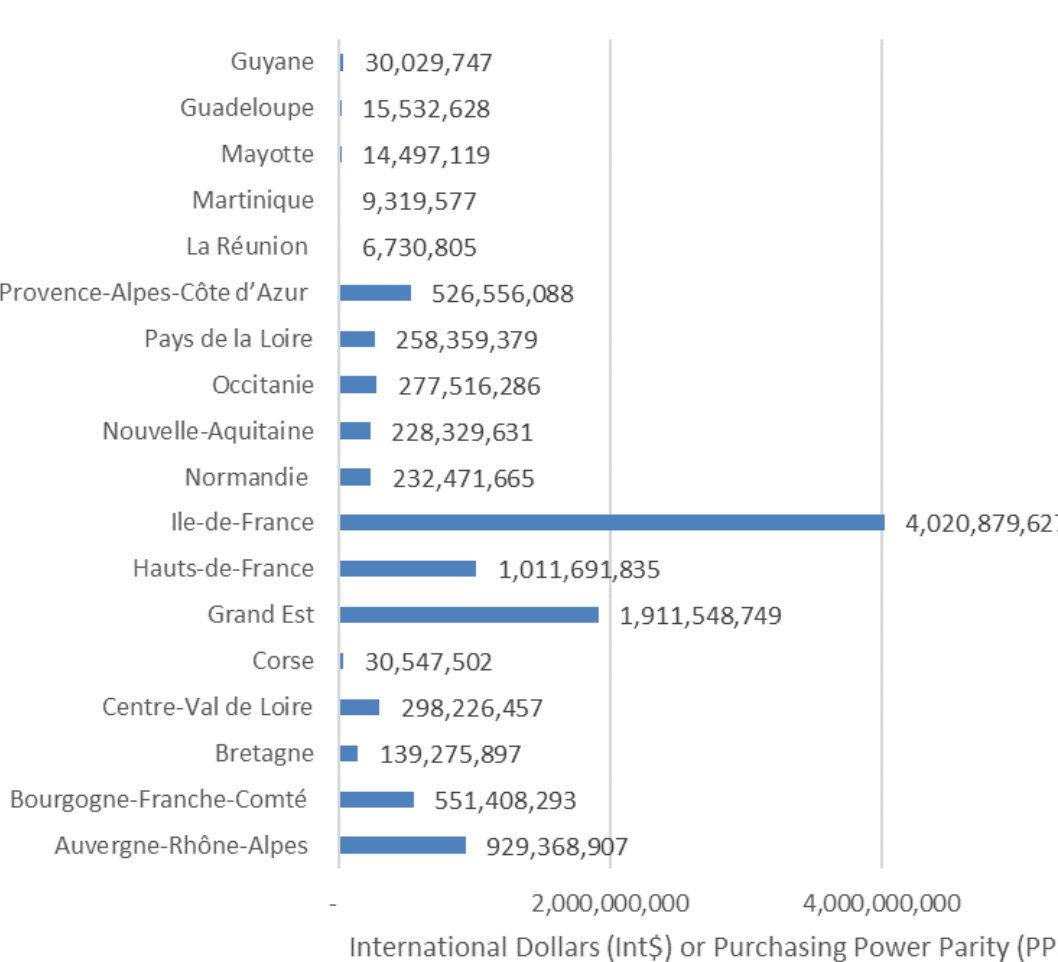
Figure 1. Regional and territorial distribution of the discounted value of human lives lost from COVID-19 in France as of 14 September 2020